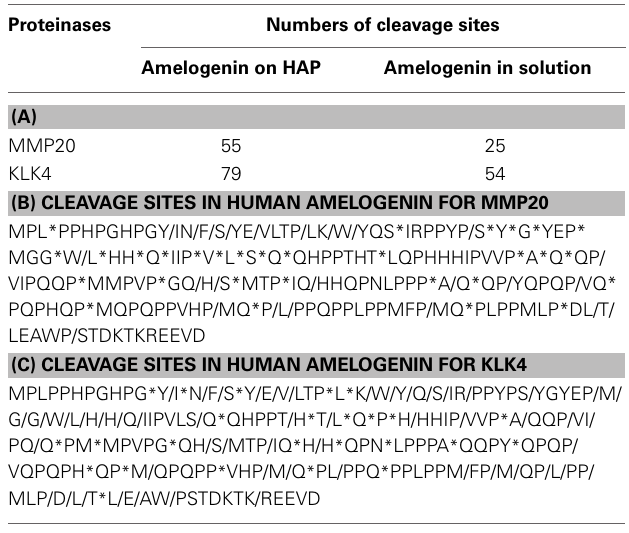
Table 1 | The numbers of cleavage sites generated by MMP-20 and KLK4 in amelogenins digested on HAP and in solution.